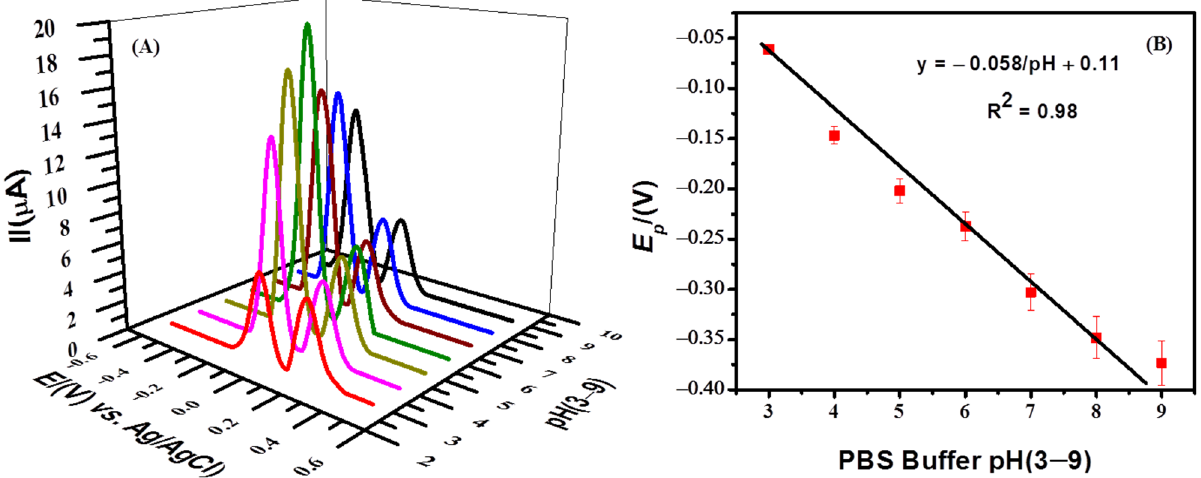
Figure 5. ( A ) SWV of 10 μ M MB in PBS solutions of pH (3.0–9.0) obtained by using NH 2 - f MWCNTs/GCE as a working electrode with deposition time of 5 s and accumulation potential of − 0.5 V. ( B ) Ep–pH plot of MB using data of Figure 5A at scan rate of 125 mV/s.